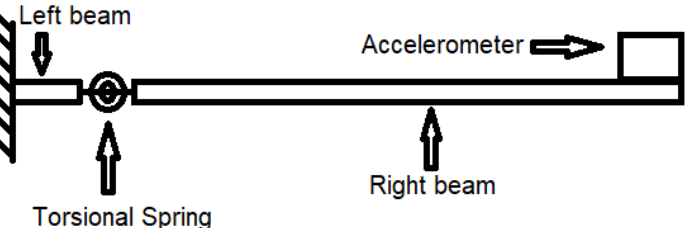
Figure 1. Simulation of a cracked cantilever beam with an accelerometer at beam free end.